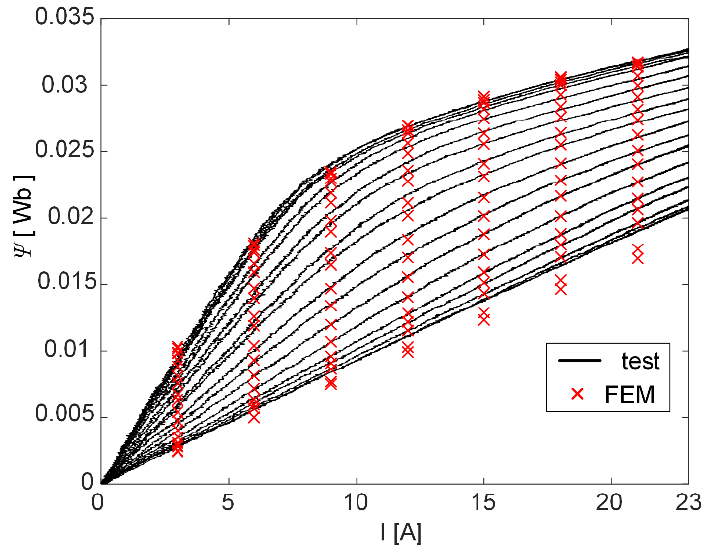
Figure 30. Flux linkage curves of 6/10 SRM obtained from static tests and FEM simulations.